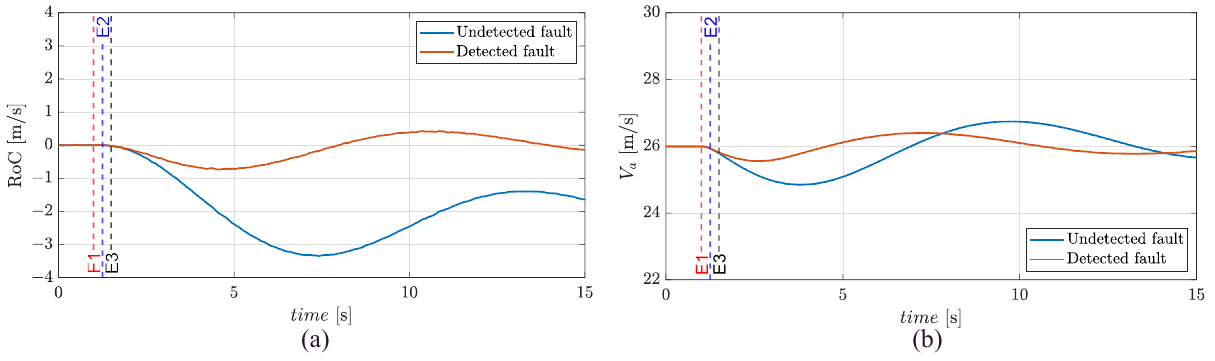
Figure 11. FEPS currents and voltages responses in climb with phase-to-ground fault on stator 2 (E1, E2 and E3 defined in Section 3.1): stator 2 currents ( a ) with I sat = 46 Arms; stator 2 voltages ( b ) with V DC = 36 V.